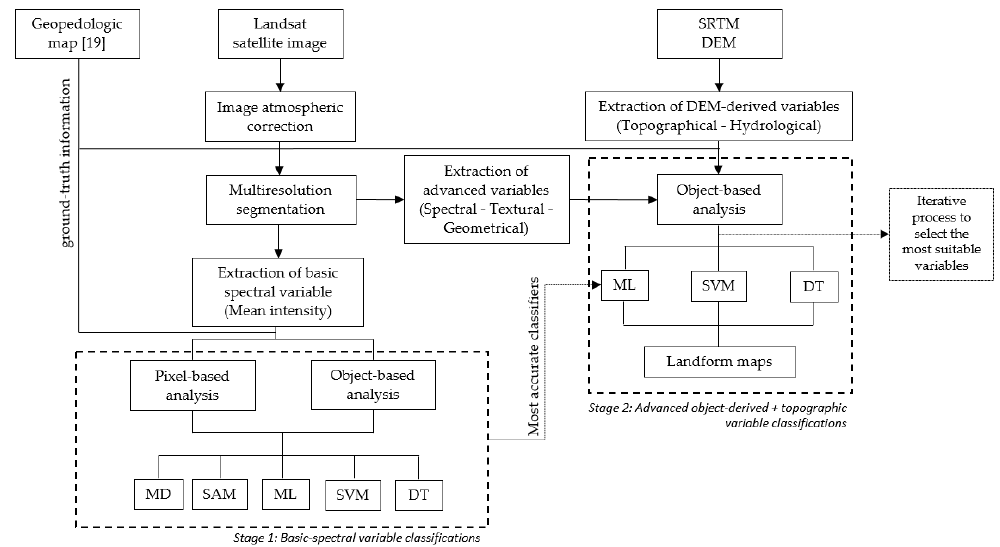
Figure 3. Processing scheme for the classification of landforms combining object-based image analysis with topographic data.